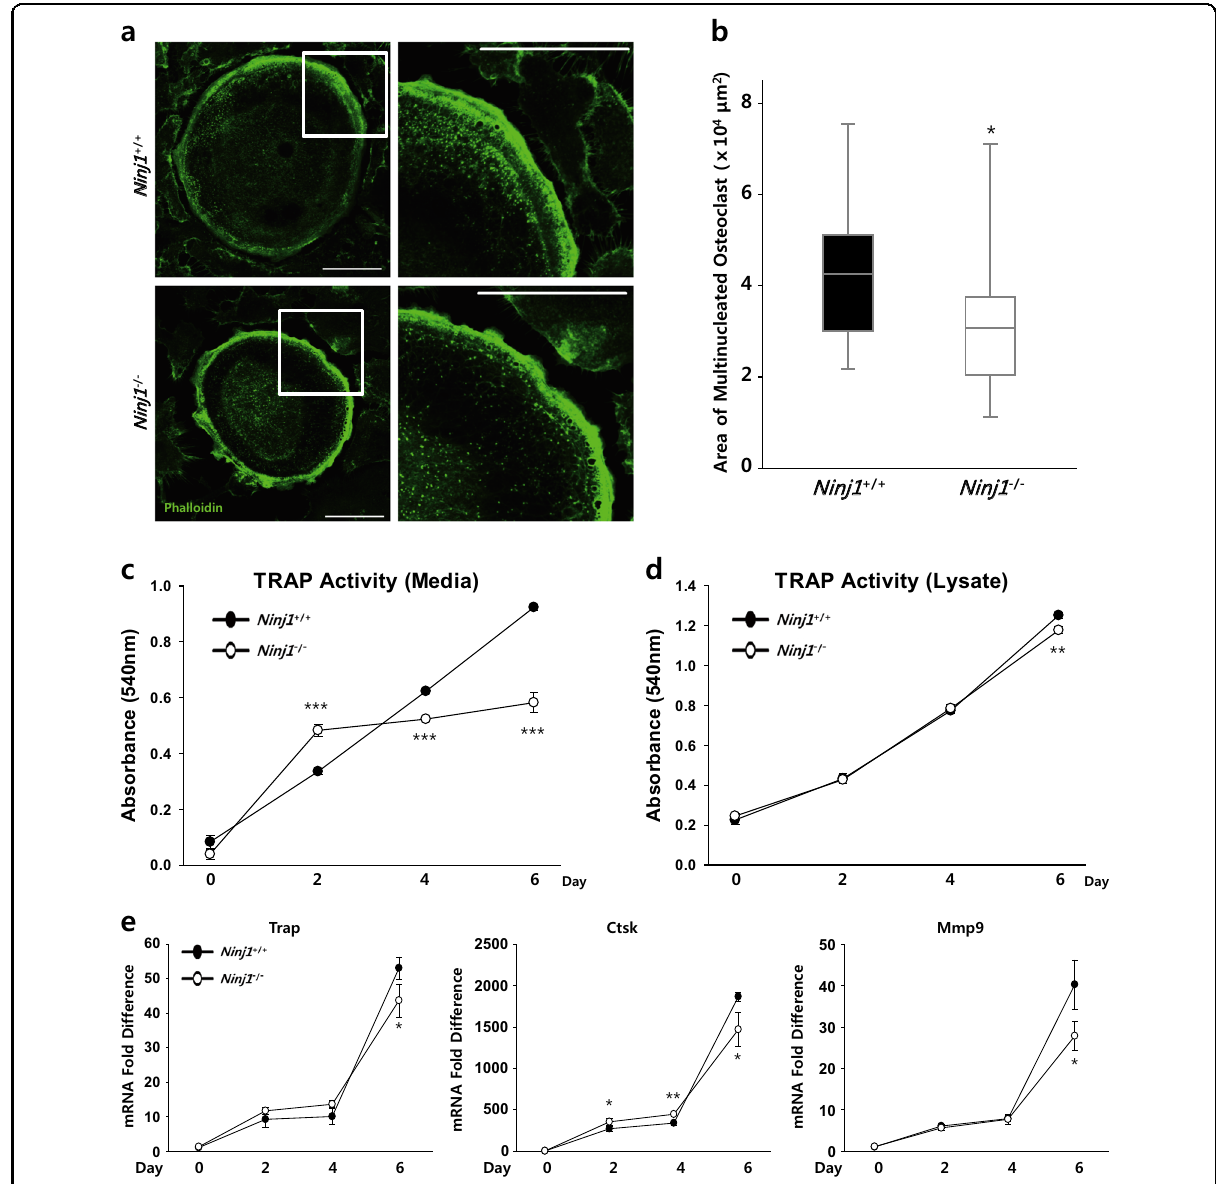
Fig. 5 Ninj1-de fi cient osteoclasts have a smaller area surrounded by an actin ring, and TRAP activity is reduced in Ninj1 − / − cell culture medium. a , b BMMs were cultured on glass coverslips with M-CSF and RANKL for 6 days. Cells were stained with AF488-Phalloidin. a Representative images of osteoclasts with actin ring formation (left) and highly magni fi ed images of the insets on the left (right). Scale bars, 50 μ m. b The area inside the actin ring formed in osteoclasts is shown in a median-quartile boxplot; * P < 0.05. c , d BMMs were cultured with M-CSF and RANKL for the indicated days. Absorbance at 540 nm was measured to assess TRAP activity. c Conditioned medium was collected on the indicated days and subjected to a TRAP activity assay. The absorbance is shown as the mean ± SD ( n = 3, with triplicates in each experiment); *** P < 0.001. d Cell lysates were harvested on the indicated days and subjected to a TRAP activity assay. The absorbance is shown as the mean ± SD ( n = 3, with triplicates in each experiment); ** P < 0.01. e mRNA expression of resorption-related osteoclast markers, including TRAP ( Trap ), Cathepsin K ( Ctsk ) and MMP-9 ( Mmp9 ), was analyzed by quantitative RT-PCR. The relative mRNA expression is shown as the mean ± SD; * P < 0.05, and ** P <